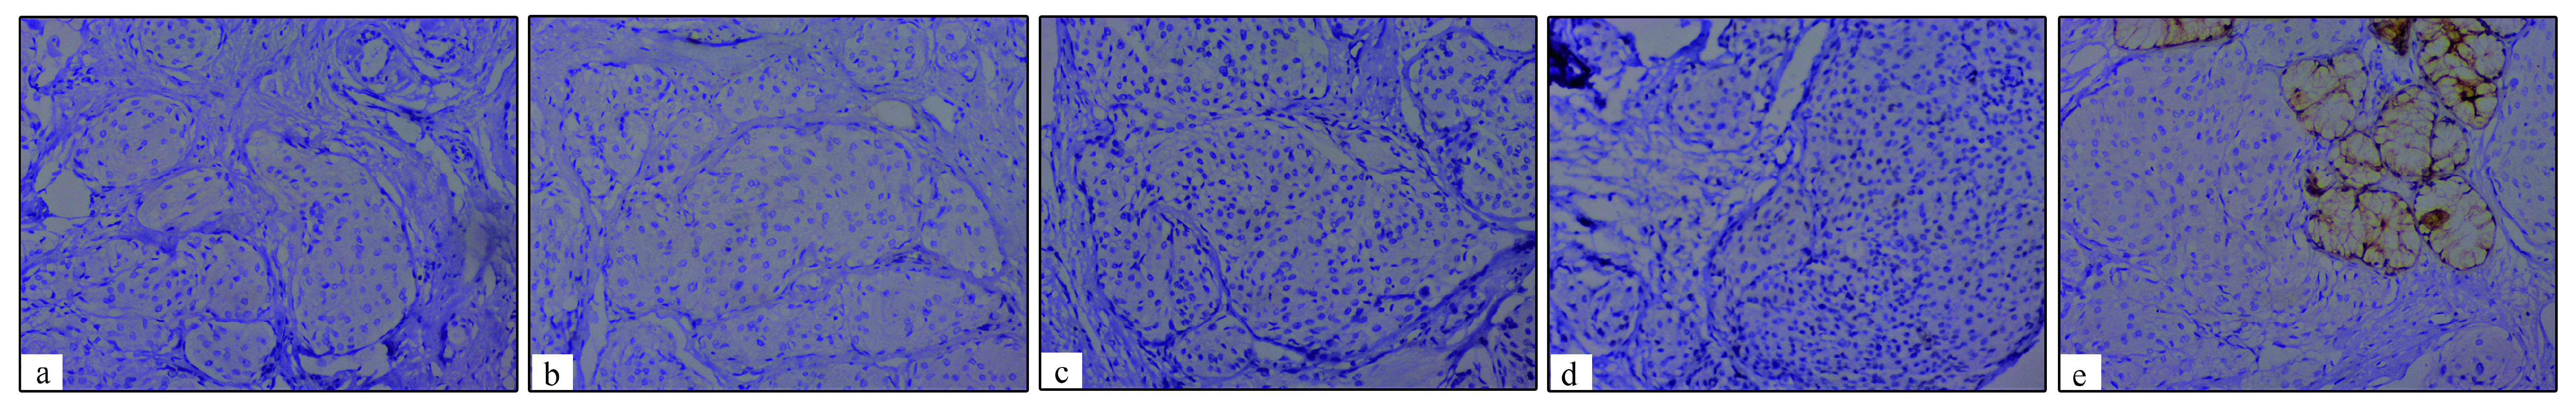
Meningioma tumor cells react negatively following immunohistochemical staining for (
a) renal cell carcinoma glycoprotein, (
b) S100, (
c) chromoginin, (
d) p63, (
e) PanCK (magnification, ×100).